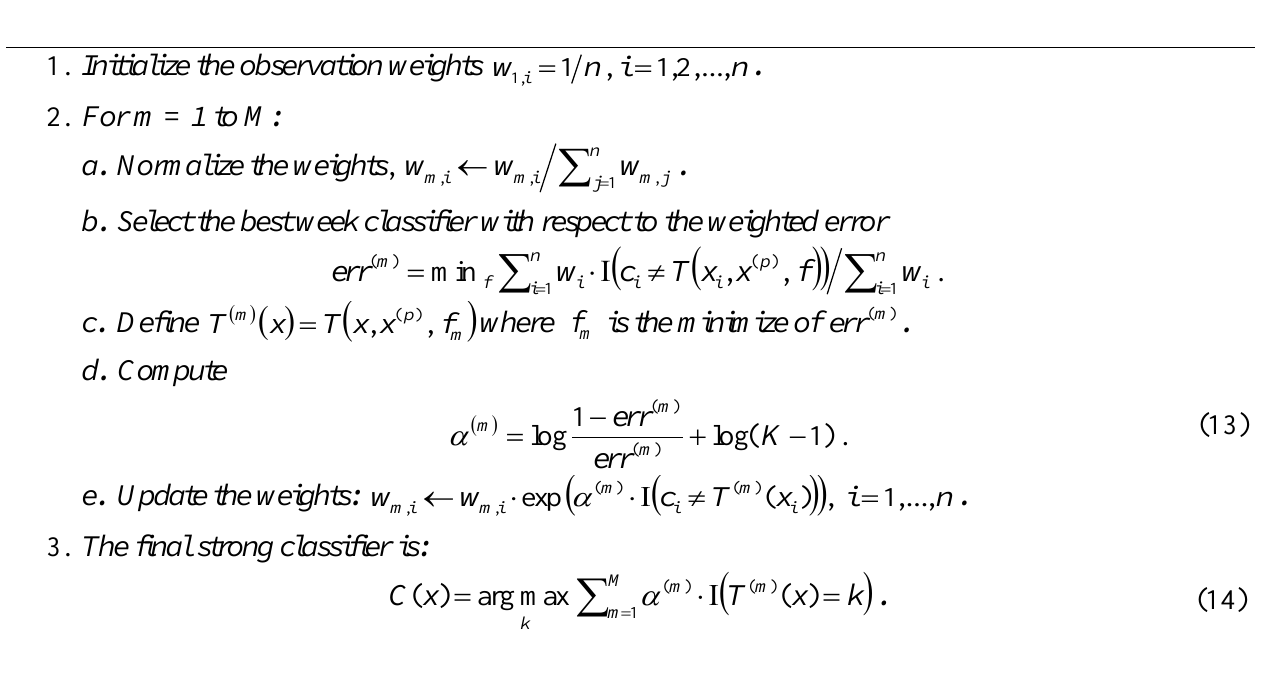
Algorithm 1. Multi-class AdaBoost learning algorithm. M hypothesis are constructed